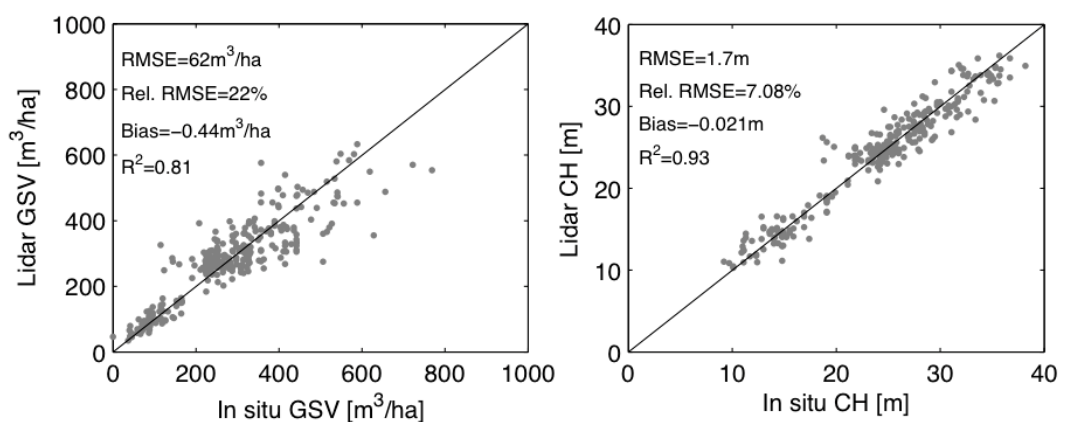
Figure 3. randomForest out-of-bag GSV and CH estimates for pine stands based on stand-level ALS canopy structure indices versus in situ GSV and